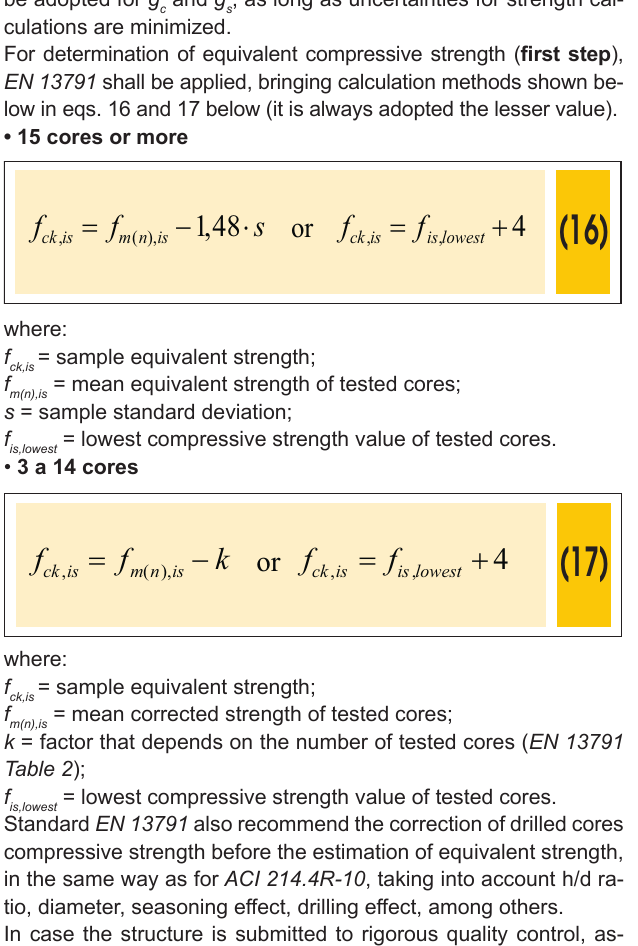
Table 5 – Utilized g factors in assessment of c existing structures (EUROCODE